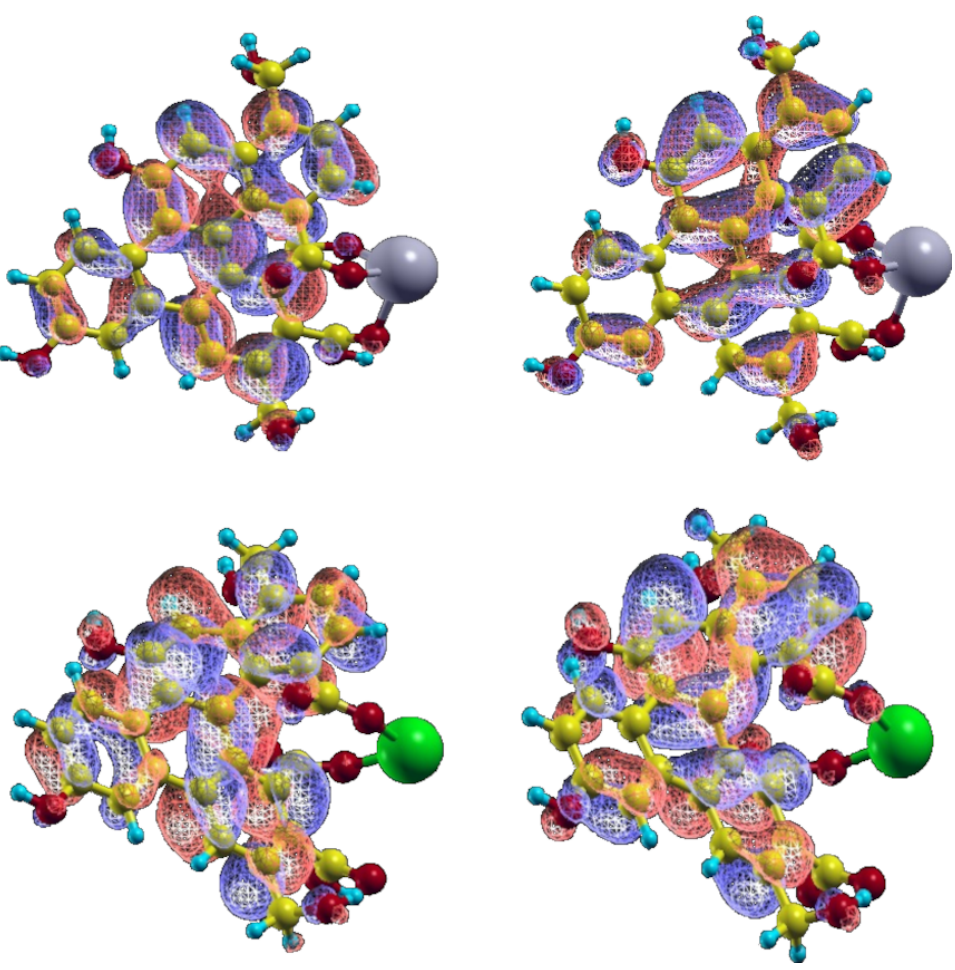
Figure 7. HOMO and LUMO density surfaces of UFQD-Pb ( top ) and UFQD-Cd ( bottom ). HOMO: right panel, LUMO: left